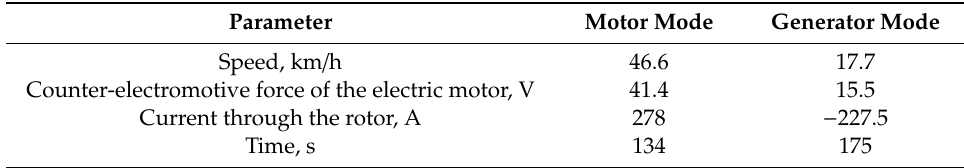
Table 4. The working point in motor and generator